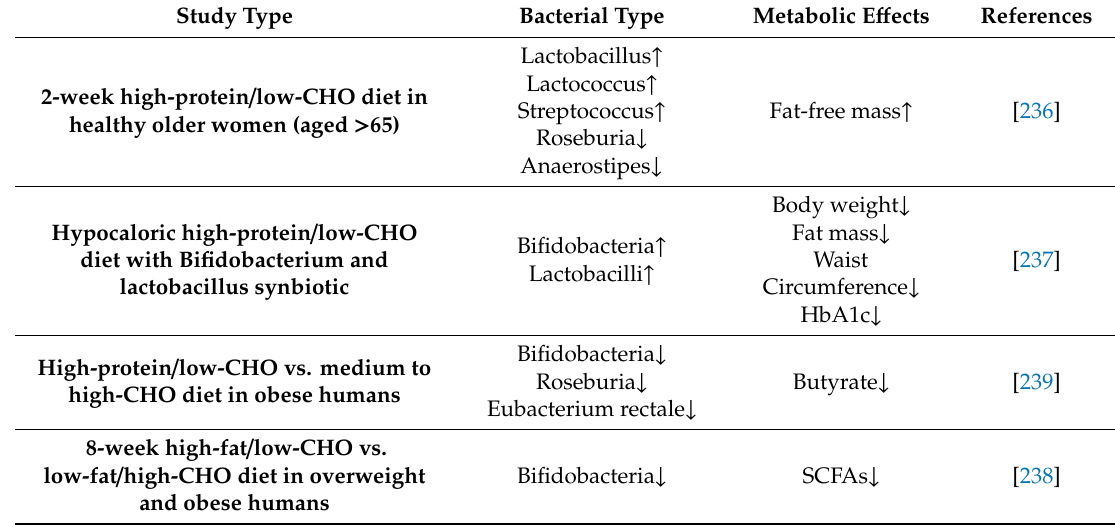
Table 2. Gut microbiota and metabolic alterations following increased protein and reduced carbohydrate